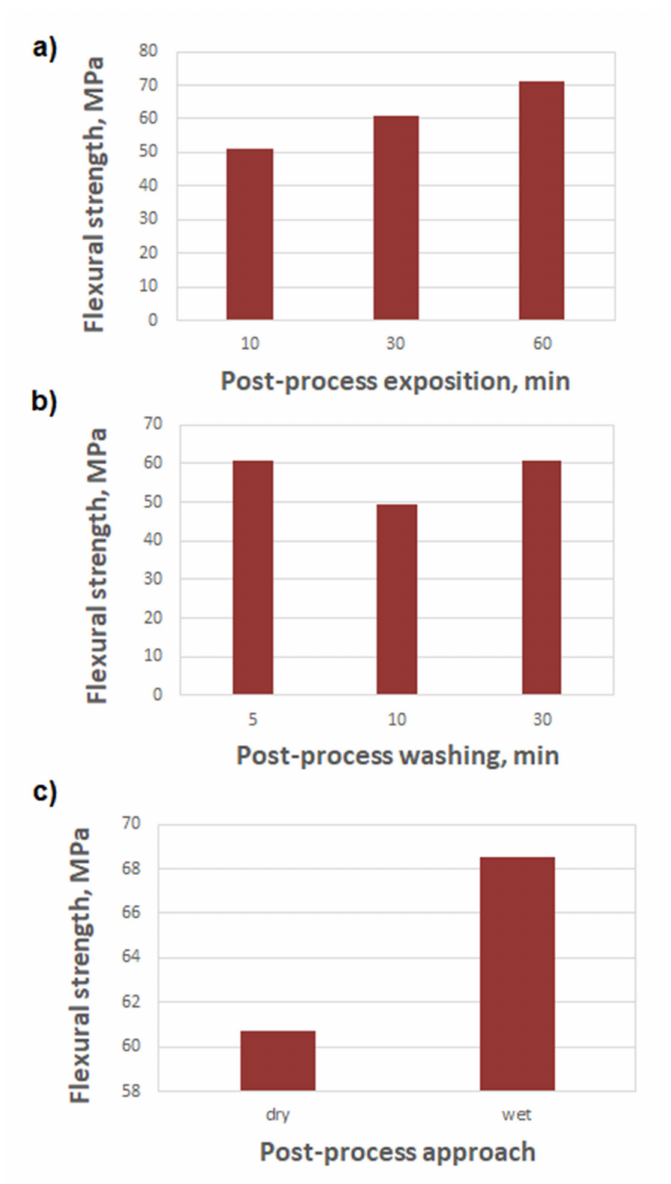
Figure 4. Flexural strength of printed samples, depending on the following: ( a ) post-curing exposition time, ( b ) post-process washing time, ( c ) post-process approach—post-curing in water